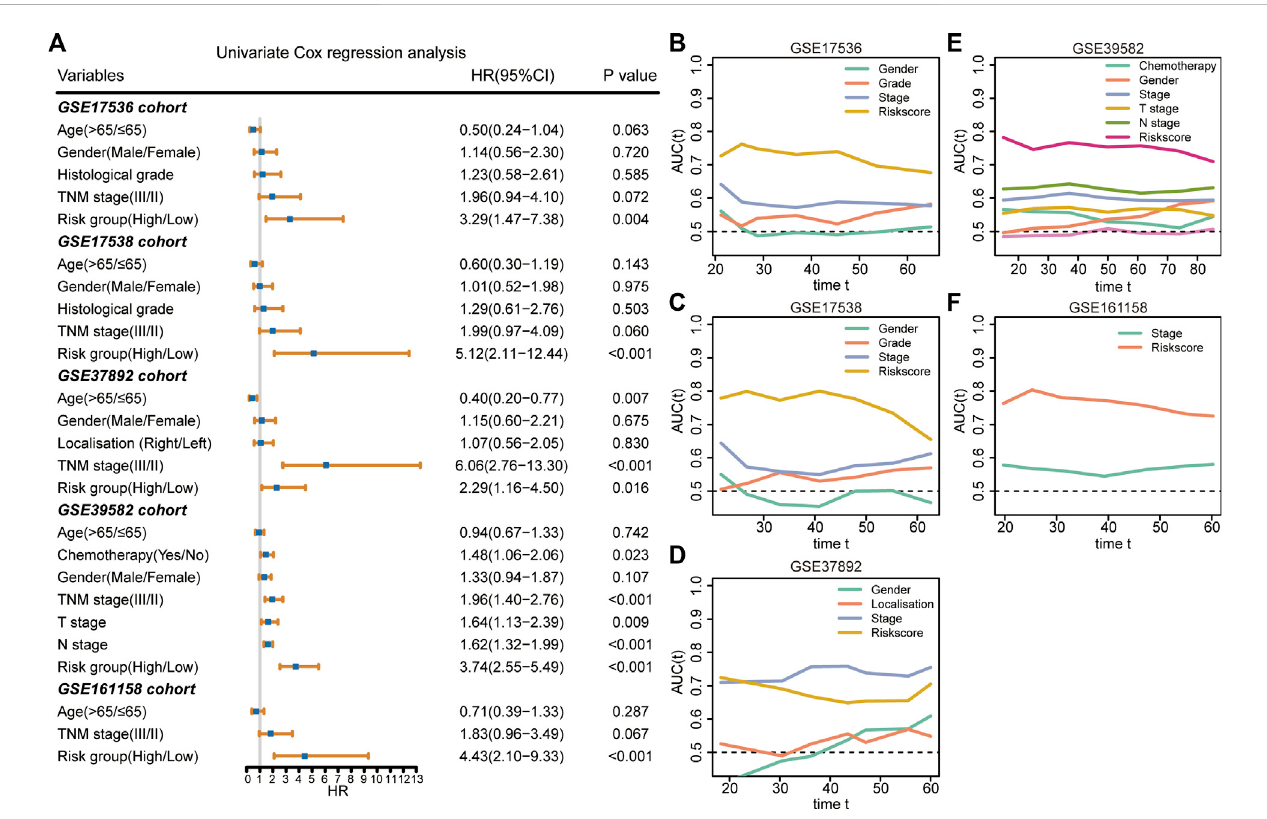
FIGURE 4 Superiority evaluation of the 9-gene signature compared with clinical factors (A) Univariate Cox regression analyses identi fi ed independent prognostic factors in each cohort. (B – F) Time-dependent AUC values of prognostic factors in GSE17536 (B) , GSE17538 (C) , GSE37892 (D) , GSE39582 (E) , and GSE161158 (F) cohorts,